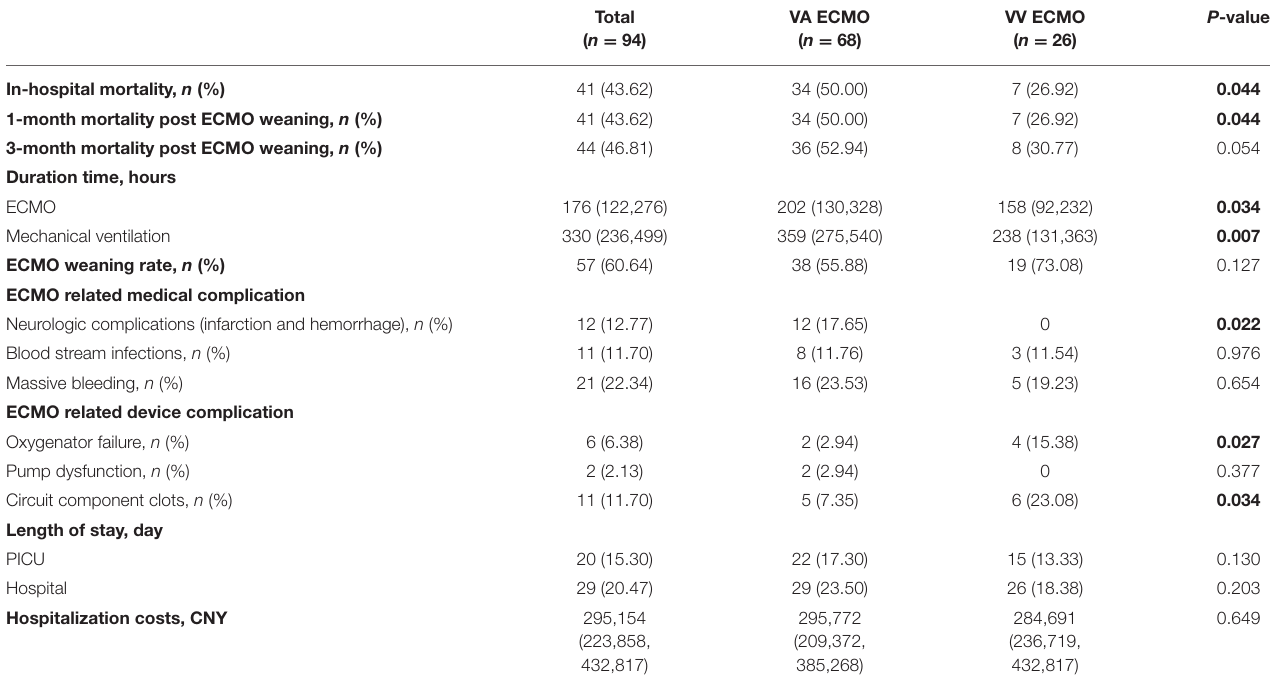
TABLE 4 | Outcomes and complications (VA ECMO vs. VV ECMO).